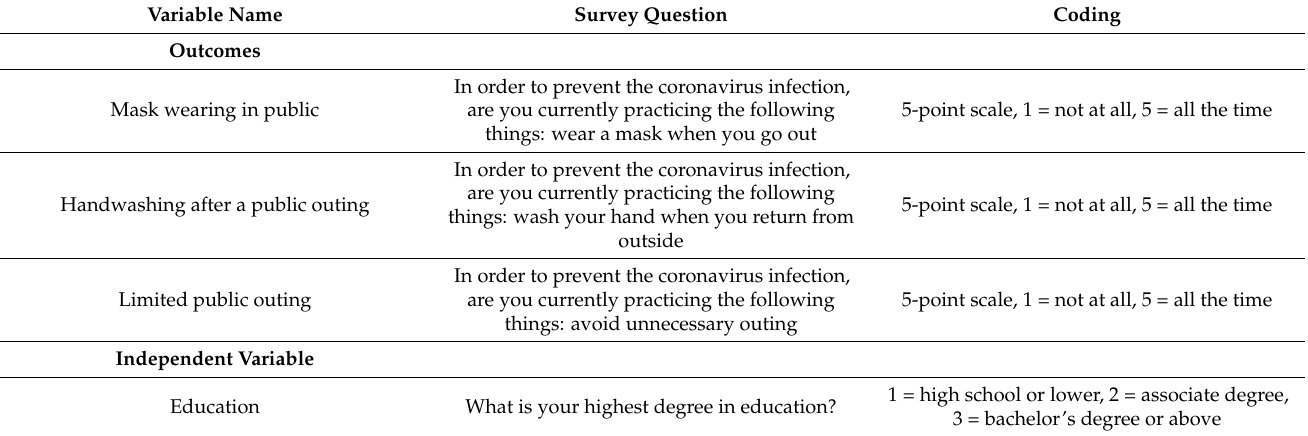
Table A1. Survey Questions for Relevant